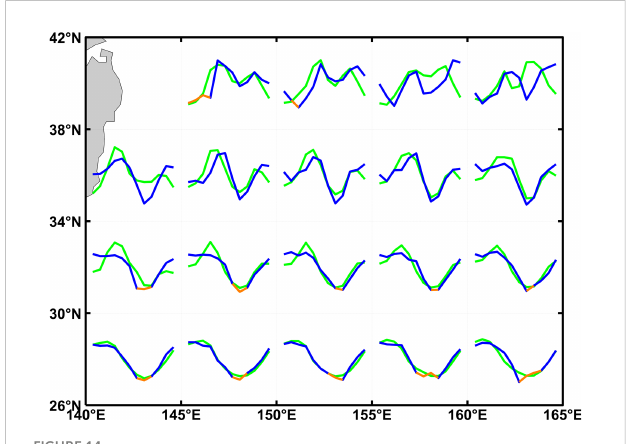
FIGURE 14 The averaged seasonal cycle of standardized surface oceanic- atmospheric partial pressure difference (blue and orange) and SCC (green) from 2003 to 2016, orange (blue) color means D pCO 2 <0 ( D pCO 2 >0) and ocean serves as a carbon source